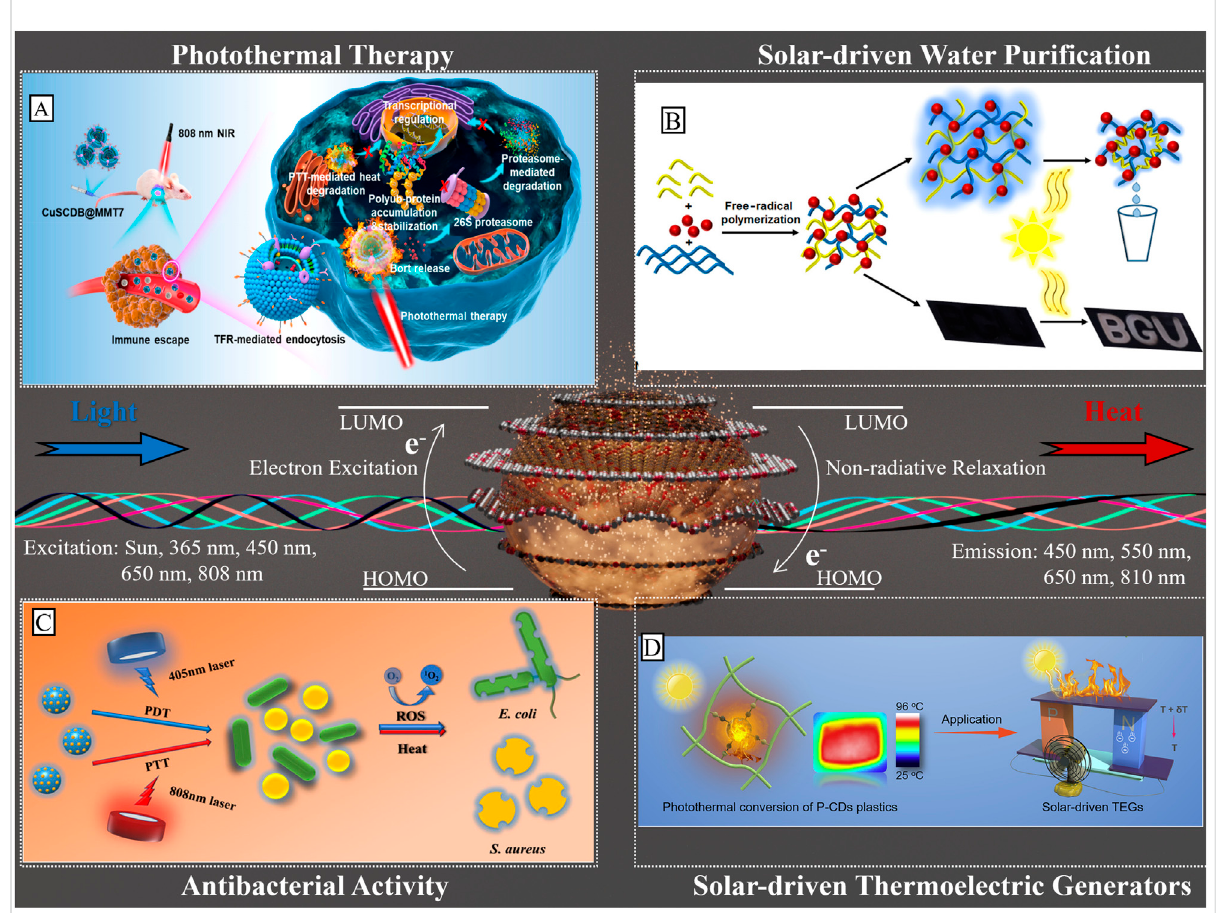
FIGURE 1 A representation of a carbon dot consisting of six disk-shaped graphite layers with both sp2-and-sp3 hybridized carbon atoms (silver spheres) beside the embedded pyridinic and pyrrolic nitrogen groups (red spheres), and the fl uorescence and heat generation upon excitation with different wavelengths oflight.The photothermalconversion ofcarbon quantum dotshas been implementedin: (A) thephotothermal degradationofatumor cell via theCuS/Carbon Dots nanocompositesunder theexcitation ofa808nm laser reprinted with permission from Yuet al. (2020), copyright 2020 American Chemical Society, (B) the solar water puri fi cation and optical switching with C-Dot — CMC — PNIPAMhydrogels under the sunlight illumination reprinted with permission from Singh and Jelinek (2020), copyright 2020 American Chemical Society, (C) Antibacterial activity of CDs/ Cur system under a combined 405, and d 808 nm laser irradiation reprinted with permission from Yan et al. (2021), copyright 2021 American Chemical Society,and (D)Solar-driven thermalelectricgeneration madepossibleby plastics integrated with carbondots (P-CDs) underthesunlight irradiation, with permission from Wan et al. (2022), copyright 2022